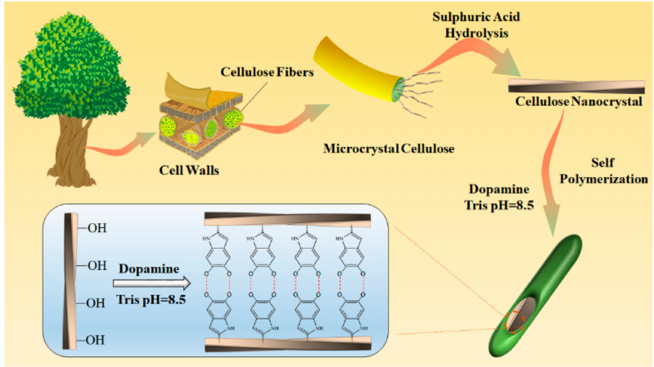
Figure 1. Illustration of the preparation process of